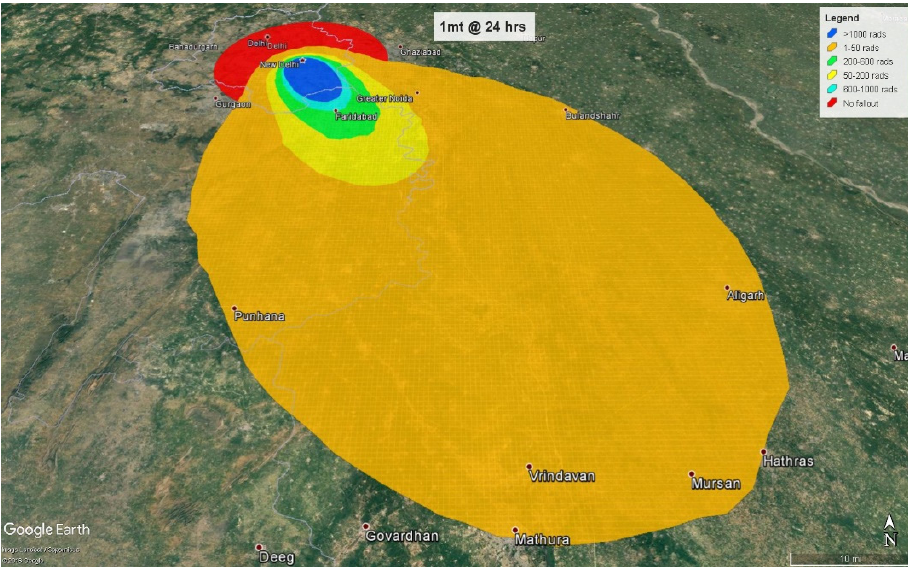
Figure 10. 1 mt fallout radiation plume at 24